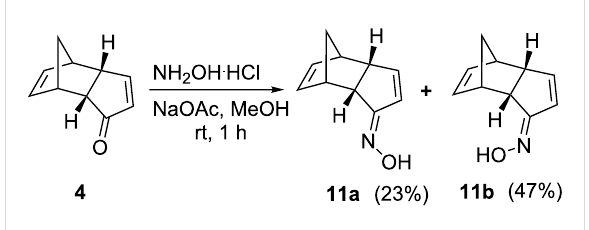
Scheme 5: Synthesis of Beckmann rearrangement precursors.